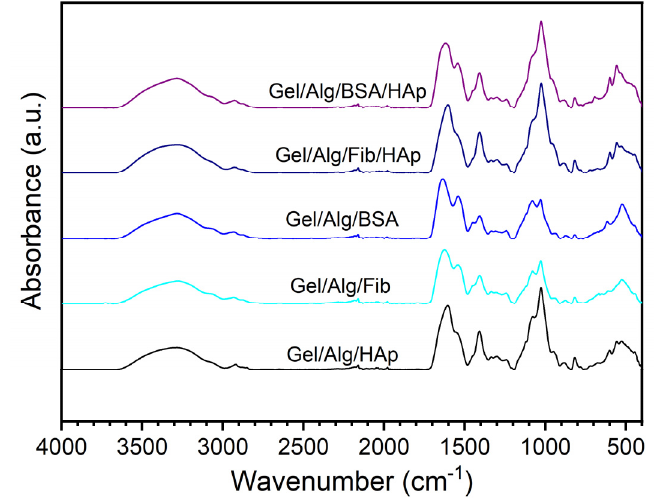
Figure 2. FT-IR spectra of di ff erent samples, from bottom to top: Gel / Alg / HAp, Gel / Alg / Fib, Figure 2. FTIR spectra of different samples, from bottom to top: Gel/Alg/HAp, Gel/Alg/Fib, Gel / Alg / BSA, Gel / Alg / Fib / HAp, Gel / Alg / BSA / Gel/Alg/BSA, Gel/Alg/Fib/HAp, Gel/Alg/BSA/HAp.